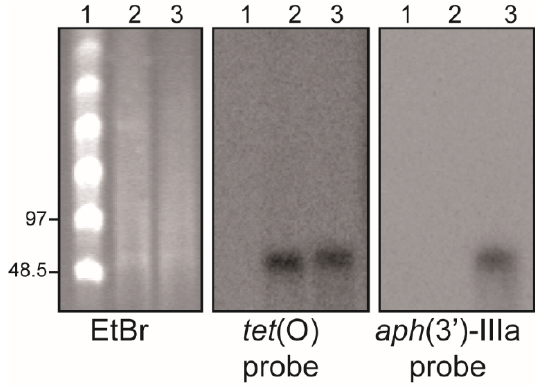
Figure 1. The HS01 isolate carries a MDR plasmid, pCjH01. PFGE-S1 hybridization with specific probes for tet (O) and aphA-3 ( aph(3 ′ )-IIIa ). Genomic DNA from the C. jejuni 81-176 strain carrying the pTet plasmid and the MDR H01 isolate was S1 digested, and linearized plasmids were separated by PFGE. The DNA was visualized by ethidium bromide (EtBr) staining and the presence of the tet (O) and aphA-3 genes was detected by hybridization using specific probes, as indicated. Lane 1, molecular mass marker (CHEF DNA Size Standard, 48.5–1000 kb, Lambda Ladder, Bio-Rad). The size of some of the bands in kilobases is indicated on the left side of the EtBr panel. Lanes 2 and 3, S1 digested genomic DNA from 81-176 and H01, respectively.